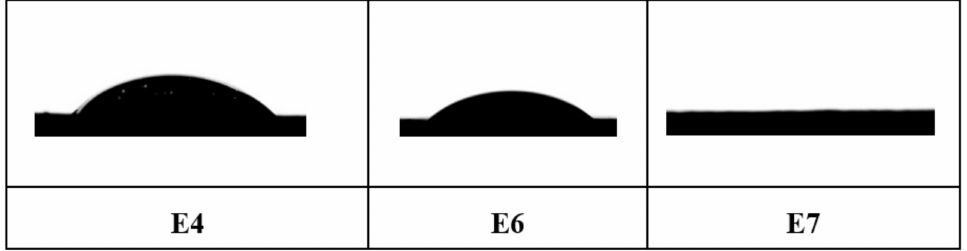
Figure 8. Contact angle images: Electrode E4, treated at 130 ◦ C, with θ = 47 ◦ , Electrode E6 treated at 250 ◦ C, with θ = 23 ◦ and Electrode E7, treated at 350 ◦ C, with θ = 0 ◦